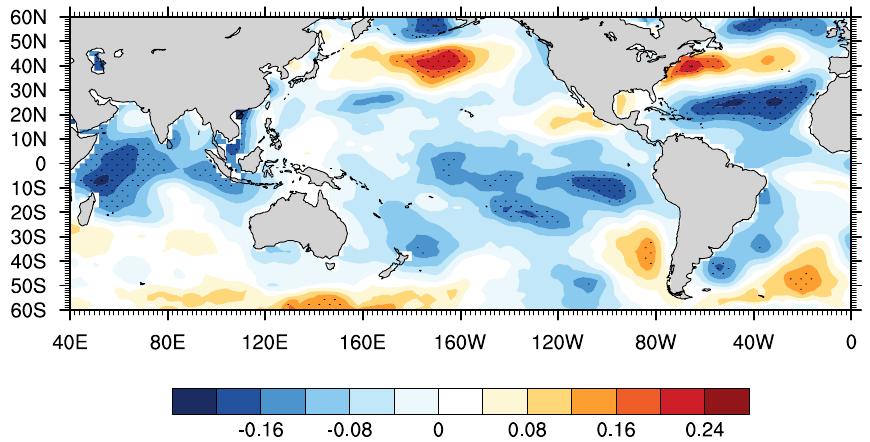
Figure 8. Spatial correlations of reconstructed series with concurrent SSTs for the period of 1870–2018. Dots indicate the correlation coefficients over a 90% confidence level. Figure is created using NCL version 6.6.2.